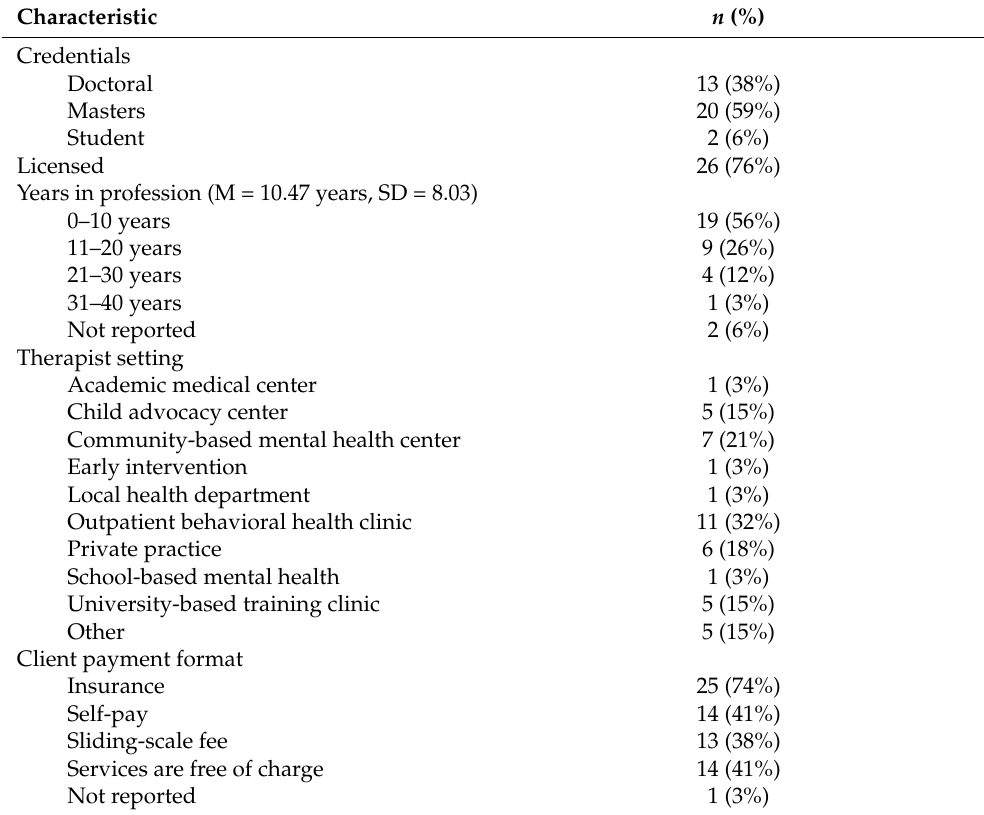
Table 1. Characteristics of Therapist Participants ( n =